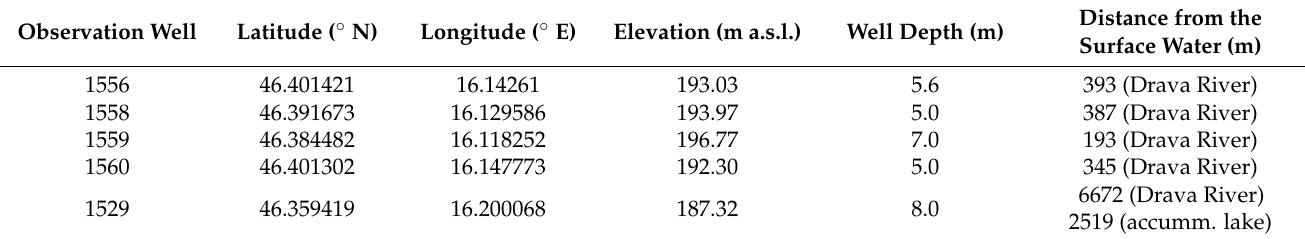
Table 3. Observation wells coordinates, depths, and distance to the surface